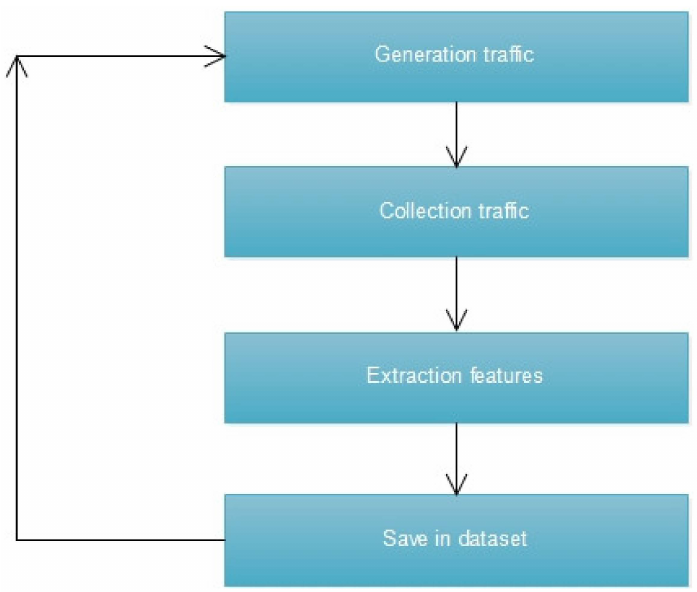
Figure 3. Stages of generating the